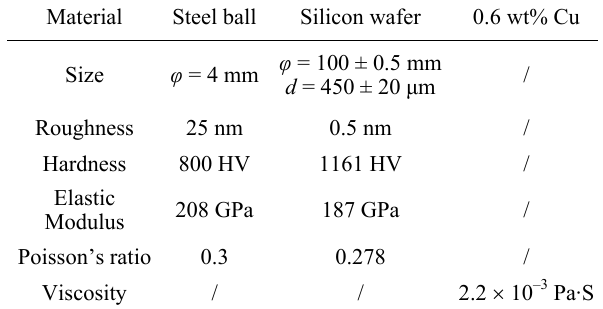
Table 1 The detail information of ball, plate and lubricants.